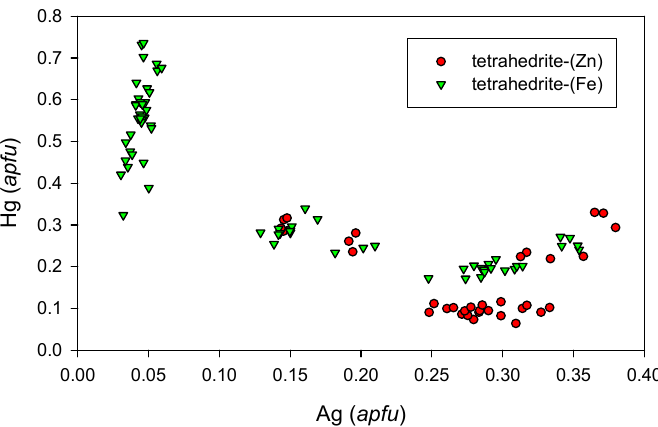
Figure 18. Ternary plot Fe–Hg–Zn ( apfu ) for members of the tetrahedrite group.